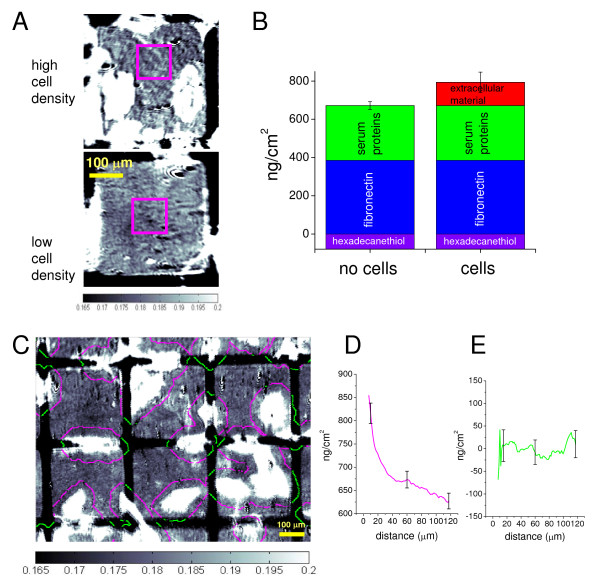
Quantitation of protein deposition using SPRI. A) Representative SPR images (using 470 nm incident light) of individual 300 μm squares of fibronectin for regions of relatively high and low cell density. Fibronectin areas are separated by areas of PEG which are resistant to protein adsorption. Image contrast is optimized to aid visualization of differences in protein deposition. The intensity values correspond to reflectivity values shown in the scale bar; reflectivity values > 0.200 appear white and < 0.165 appear black. To determine the amount of protein added to the surface during 24 h in the presence of cells, a 100 μm square region of interest (magenta box) adjacent to cells was selected, and SPR reflectivity within the blue box was averaged and converted to mass/area. A similar region was selected from a region with no cells. B) Bar graphs show that mass of material added to the surface at different steps, and in areas largely devoid of cells and areas containing cells. Mean values and standard deviations are the result from 5 imaged areas. C) Image analysis is used to quantify protein deposition at the cell periphery after 24 h in culture by dilating the cell contours to extract protein mass versus distance from the cell edge in a region where 18% of the area is occupied by cells (approximately 25 cells per field of view). Sequential dilation operations are performed in 1-μm increments. The magenta-colored contours overlay fibronectin regions; green contours overlay PEG-thiol regions. The lines shown around the cells correspond to a distance of 40 μm from the cell edges. Protein coverage in ng/cm2 is determined from the average reflectivity values for each sequential contour. Protein versus distance from cell edge is shown for fibronectin-coated regions (D). The corresponding plot in green is for the PEG-thiol regions (E). The error bars represent the standard deviation from 4 different sample regions. Scale bars = 100 μm. See text for a more complete description of the collection of these data.